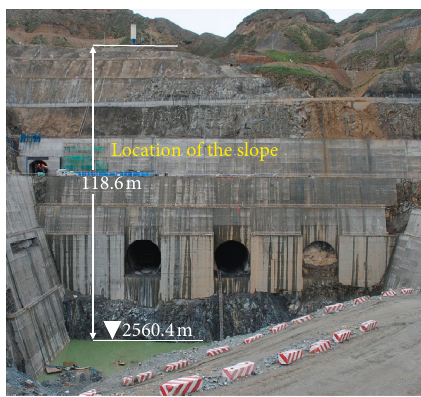
Figure 1: The rock slope of Yangqu hydropower